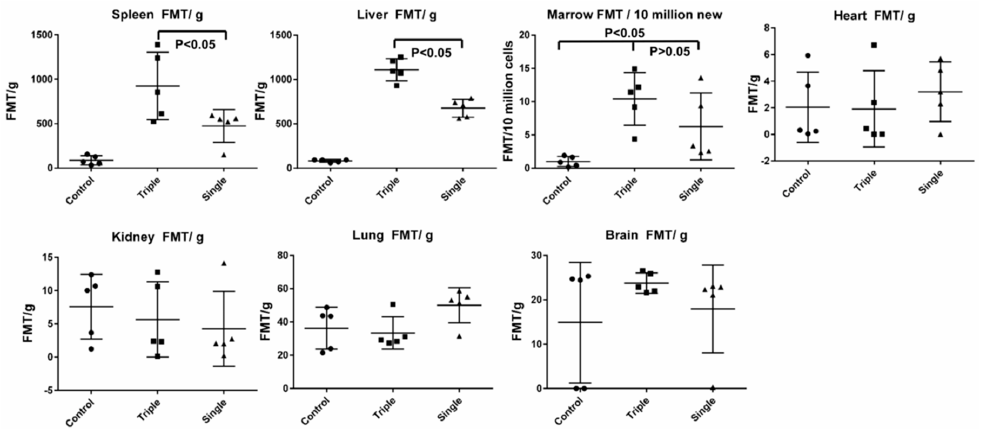
Figure 9. EV accumulation in tissues from mice with single versus triple EV injections. The intensity of fluorescence was expressed as the average of fluorescence intensity (count / energy) / weight of tissue or 10 million bone marrow cells ± SEM; n = 5 mice/group. The results were analyzed by one-way ANOVA with multiple comparisons test; A P value ≤ 0.05 was considered statistically significant, triple versus single dose in spleen and liver.